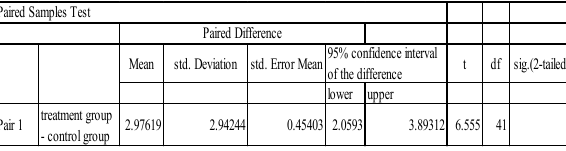
Figure 2: The number